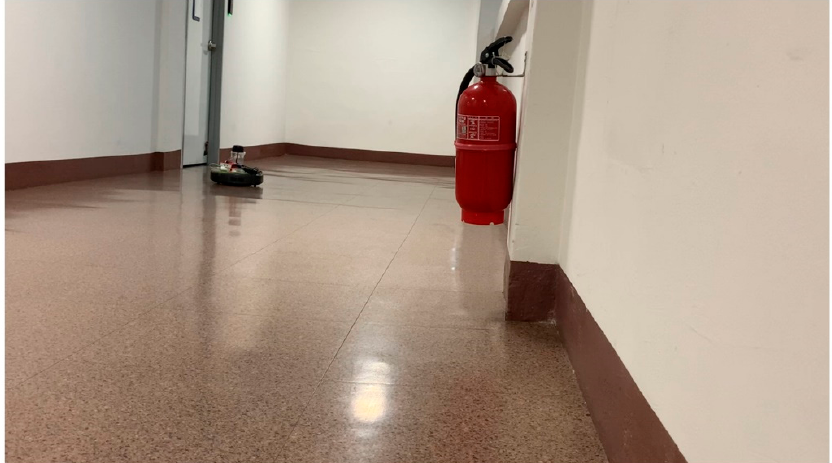
Figure 25. Environmental data result ( left ), captured image ( middle ) and scanned result ( right ) at initial position from which second autonomous scanning experiment was performed.